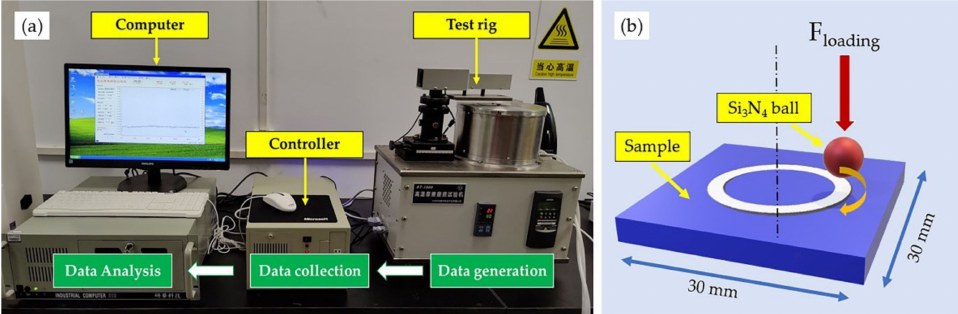
Figure 4. Friction and wear tester: ( a ) Overview of the equipment; ( b ) Schematic illustration of the test